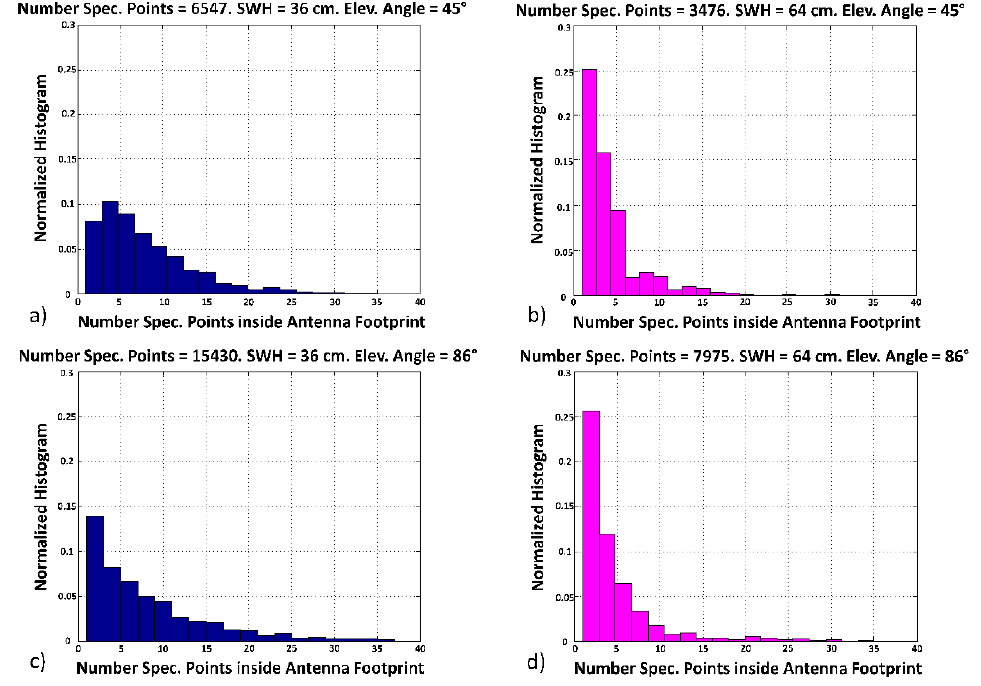
Figure 6. Specular points distribution computed using the temporal series of data provided from the HR Wallingford wave probe monitor for a: ( a ) SWH = 36 cm and θ ( b ) SWH = 64 cm θ = 45°; ( c ) SWH = 36 cm and θ e = θ e